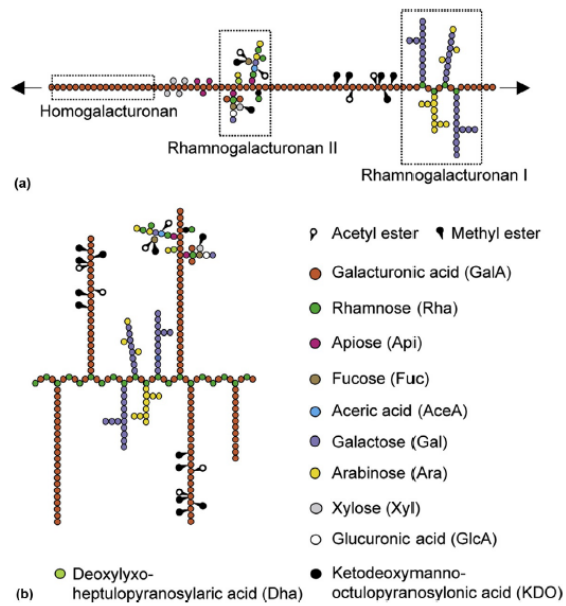
Figure 3. Comparison between ( a ) the traditional and ( b ) the modern pectin model (reproduced with copyright permission from Willats et al. [64]).